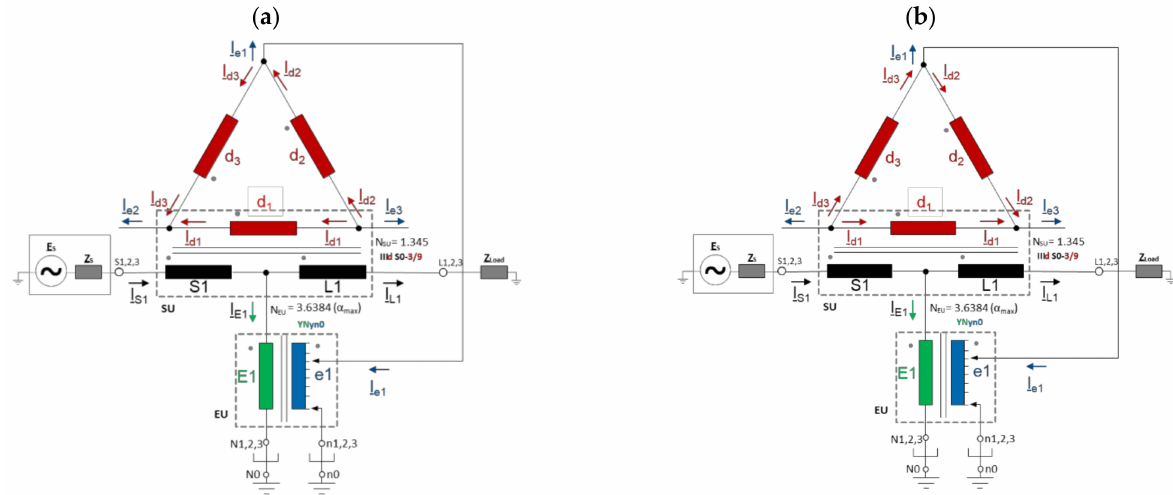
Figure 8. Symmetrical dual-core PST single line diagram for current distribution investigation (only 1-ph shown) for ( a ) advance and ( b ) retard